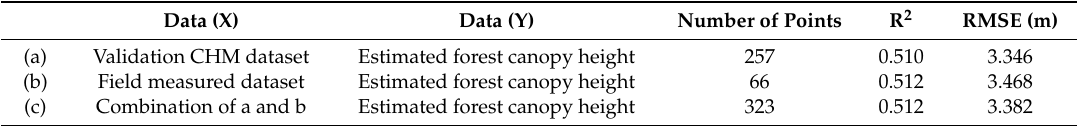
Figure 11. Independent accuracy validation for the estimated forest canopy height. Blue dots in ( a ) were derived from part of the CHM dataset; blue dots in ( b ) were derived from field measured plots; ( c ) combines the blue dots from ( a , b ). Table 6. Statistical results of comparison of DSM and ground photon average height values with GEDI data.